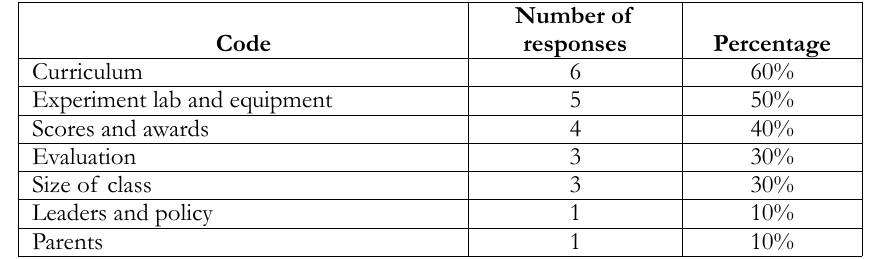
Table 9. External factors affect teaching and learning